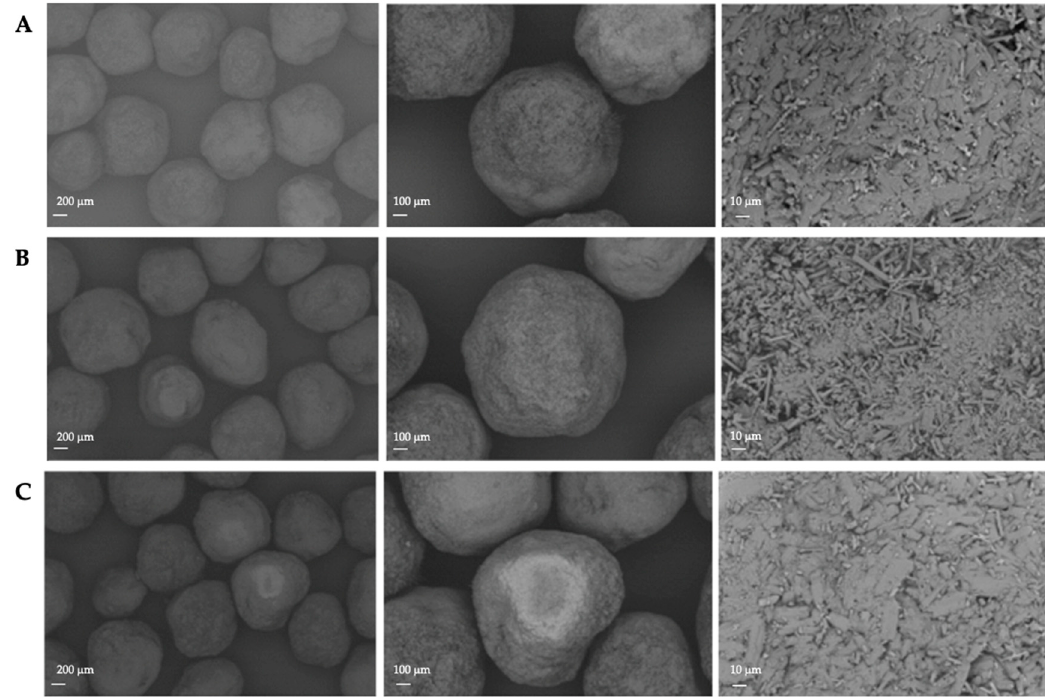
Figure 11. SEM pictures of spheronised particles (NAM: MCC) of three different runs ( A – C ) with the same process parameter constellation. Extrusion: screw design L1, screw speed 200 rpm, hopper speed set to 270 (6.6 g/min); Spheronisation: speed 100%, load 15 g, time 3.5 min. Magnification: 50-times, 100-times and 1000-times from left to right.